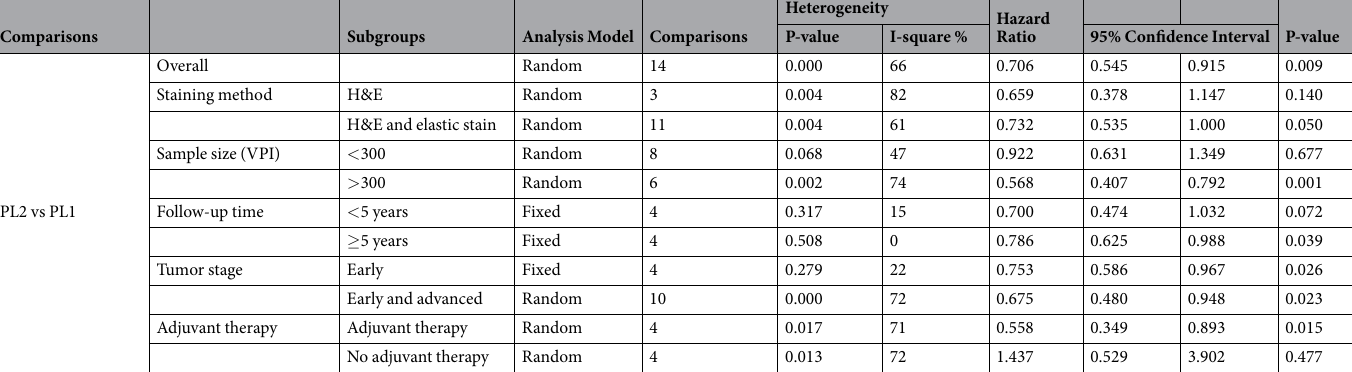
Table 2. Summarized results of subgroup analyses. * H&E: hematoxylin-eosin staining; VPI: Visceral pleural